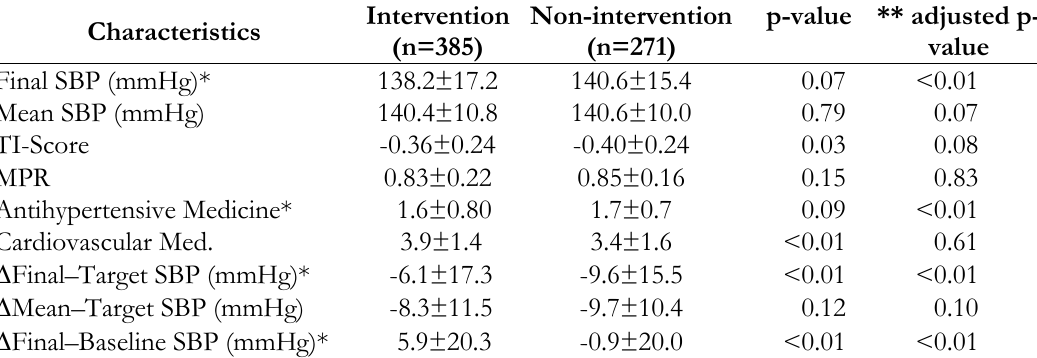
Table III. Post-intervention profile and the reduction of blood pressure between intervention vs.